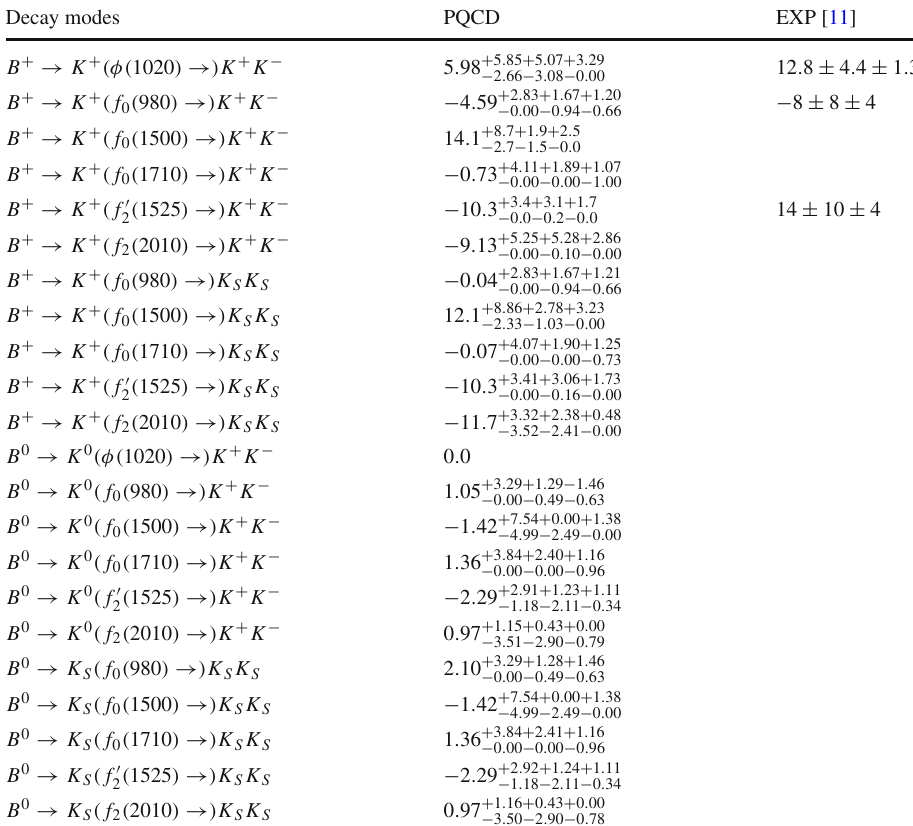
Table 2 The local CP asymmetries (in %) of various B → K + / 0 ( R → ) K + K − / K S K S decays